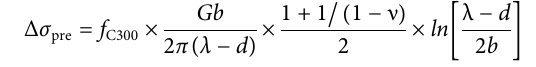
Frontiers in Materials |